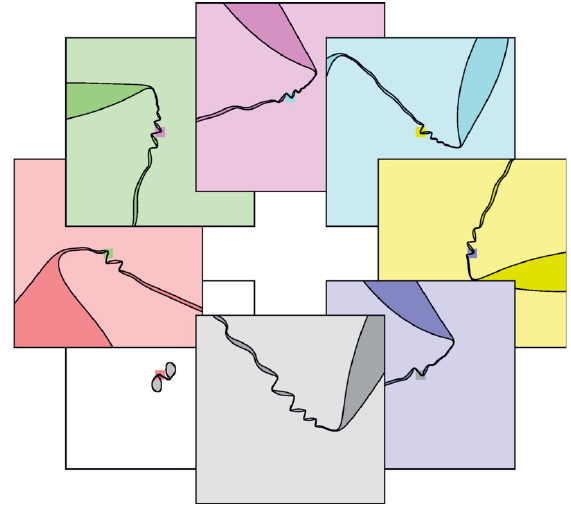
Figure 1. Cascade of filament instabilities near the time of singularity (infinite curvature). On the bottom left (box with white background), two elliptical vortices are elongating a thin filament. Each panel in clockwise order shows a close-up of the filament. Finer and finer scale structures can be observed with the rolling-up of the filament. Reprinted with permission from [31]. Copyright (2014) by the American Physical Society